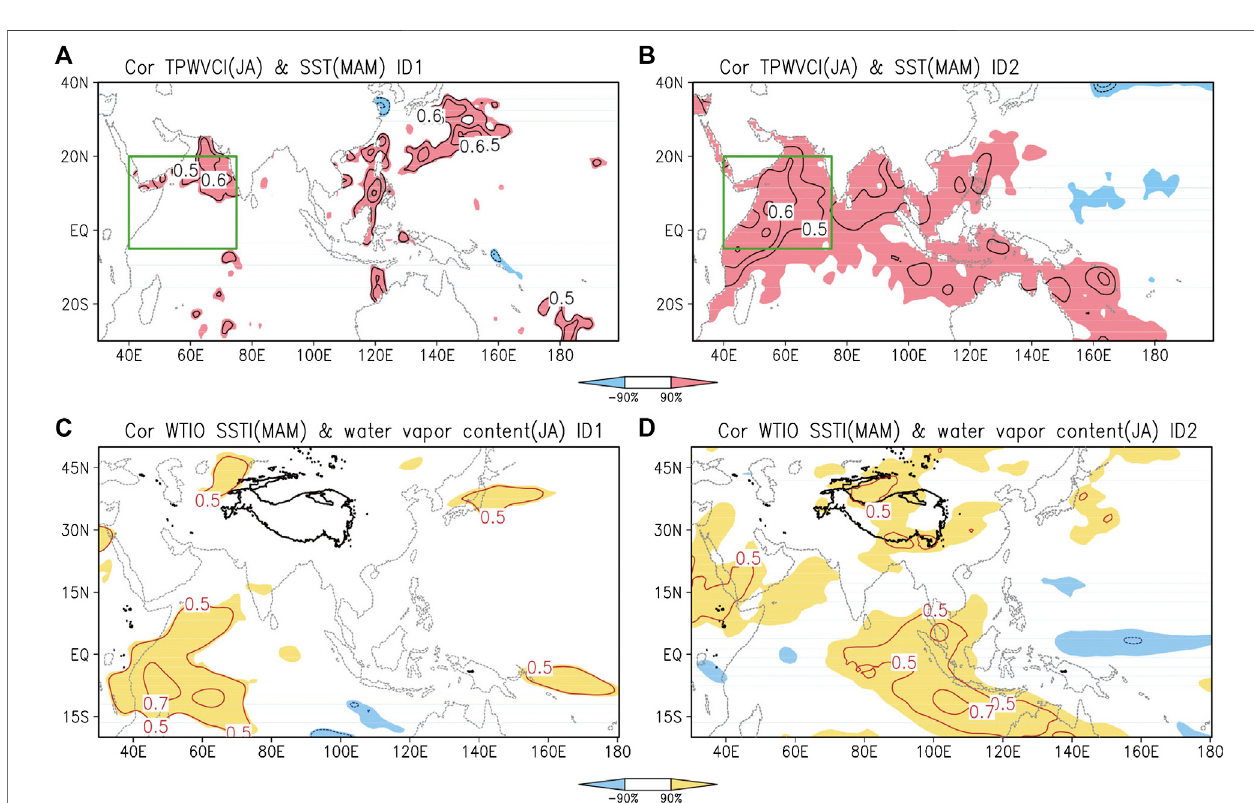
FIGURE 4 | Distributions of the correlation coef fi cients between the spring SST and TPWVCI for (A) ID1 and (B) ID2, (C) and (D) are same as (A) and (B) but for the correlationcoef fi cients betweenthesummerwatervapor contentandWTIO SSTI.Contours indicate values > (cid:2) 0.5. Shaded areas indicate correlations thathavepassed the test at 90% con fi dence level. Green boxes in (A), (B) indicate the domain of SST.